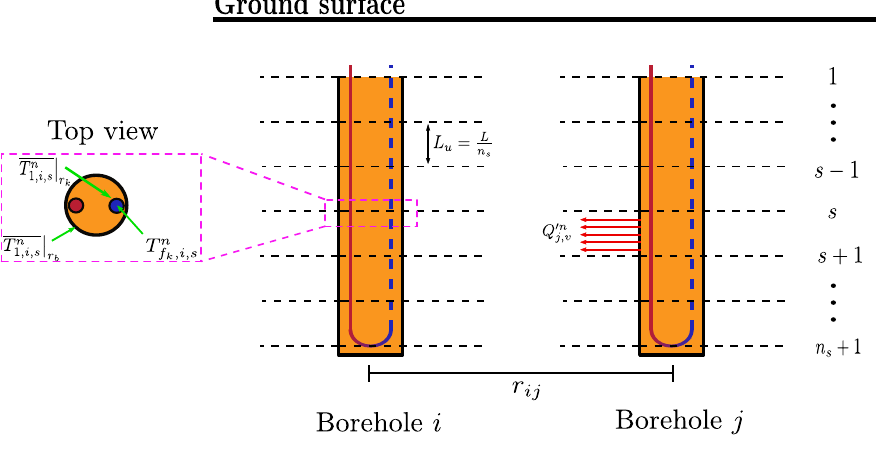
Figure 3. ( n s ) segments discretization of boreholes i and j